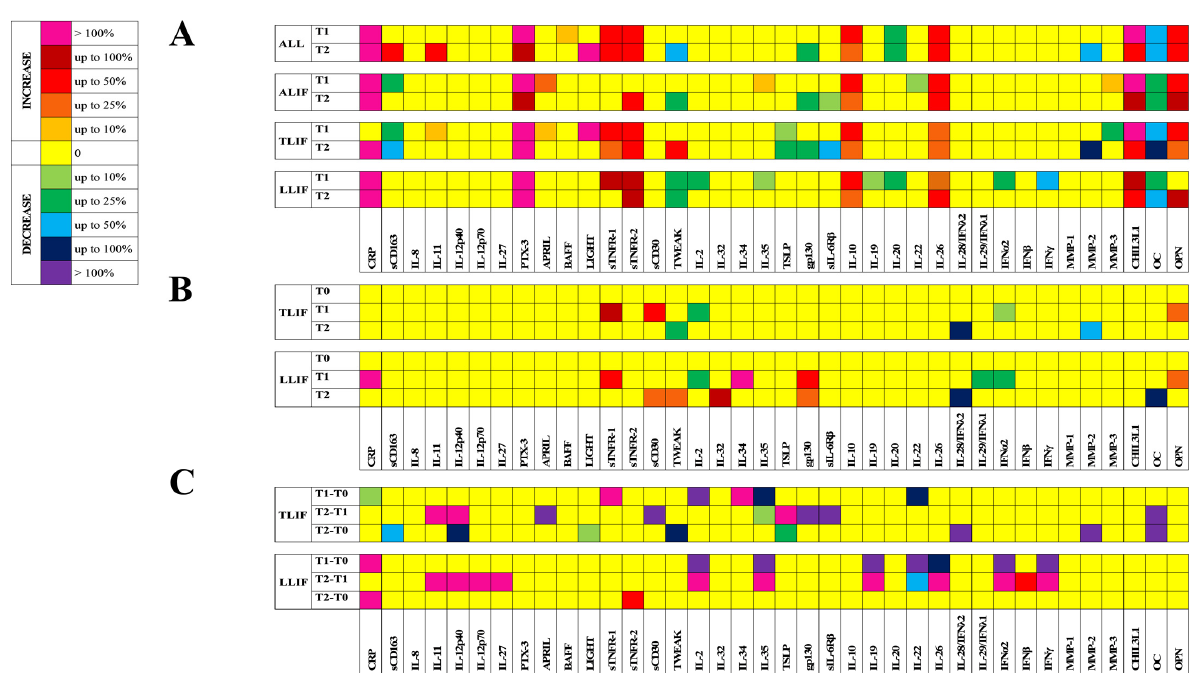
Figure 2. Inflammatory markers, cytokines, cytokine receptors and co-receptors, and tissue remodeling factors. ( A ) Comparison of the inflammatory mediators’ profiles with the relative baseline value (T0) in the whole cohort (ALL), and in the three approaches (ALIF, TLIF, and LLIF). ( B ) Comparison of the inflammatory mediators’ profiles with ALIF, at each time-point. ( C ) Comparison of the amplitude of changes, between the different time-points (T1–T0, T2–T1, T2–T0) of the inflammatory mediators’ profiles with those of ALIF. The color scale indicates the degree of percentage variation. ALIF: Anterior Lumbar Interbody Fusion; TLIF: Transforaminal Lumbar Interbody Fusion; LLIF: Lateral Lumbar Interbody Fu- sion; CRP: C-reactive protein; sCD: soluble cluster of differentiation; IL: interleukin; PTX-3: pentraxin-3; APRIL: a prolif- eration-inducing ligand; BAFF: B-cell activating factor; LIGHT: homologous to lymphotoxin, exhibits inducible expression and competes with HSV glycoprotein D for binding to herpesvirus entry mediator, a receptor expressed on T lymphocytes; sTNFR: soluble tumor necrosis factor receptor; TWEAK: tumor necrosis factor-related weak inducer of apoptosis; TSLP: thymic stromal lymphopoietin; gp130: glycoprotein 130; sIL-6R β : soluble interleukin 6 receptor β ; IFN: interferon; MMP: matrix metalloproteinases; CHI3L1: chitinase-3-like protein 1; OC: osteocalcin; OPN: osteopontin.